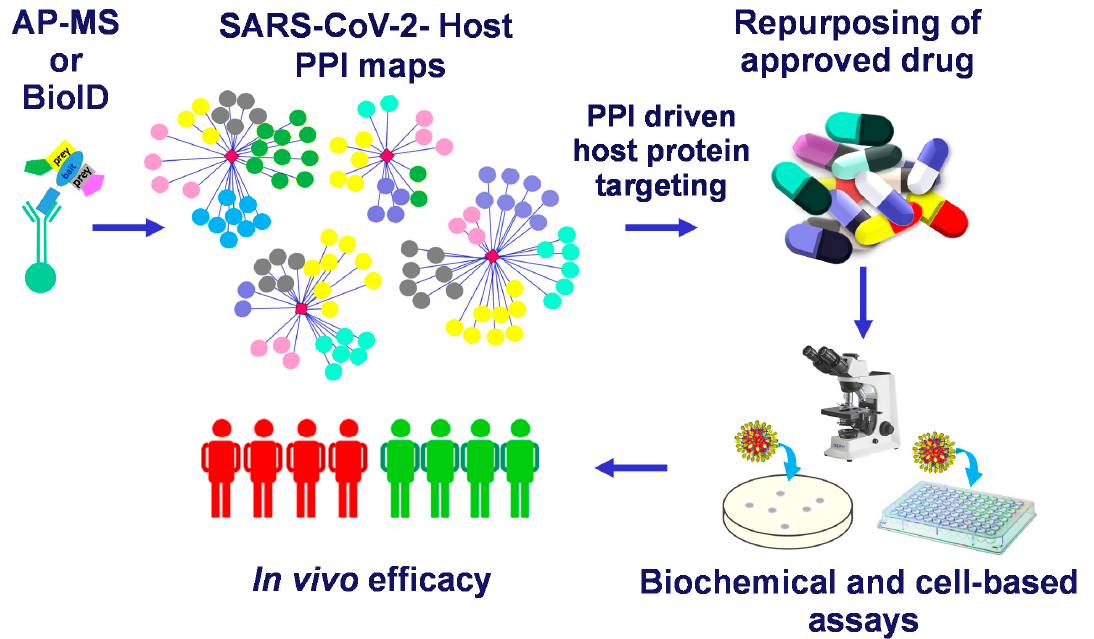
Figure 2. Overview of PPIs-based drug repurposing. SARS-CoV-2 interactomes are generated by affinity purification Mass Spectrometry (AP-MS) or by Proximity-Dependent Biotin Labeling (BioID). Interactions between SARS-CoV-2 viral baits proteins and host proteins targetable by already approved drugs are selected. Next, druggable host targets are analysed by biochemical and cell-based assays for antiviral activity. Selected lead compounds with in vitro anti-viral efficacy are then tested for in vivo efficacy on COVID-19 patients.